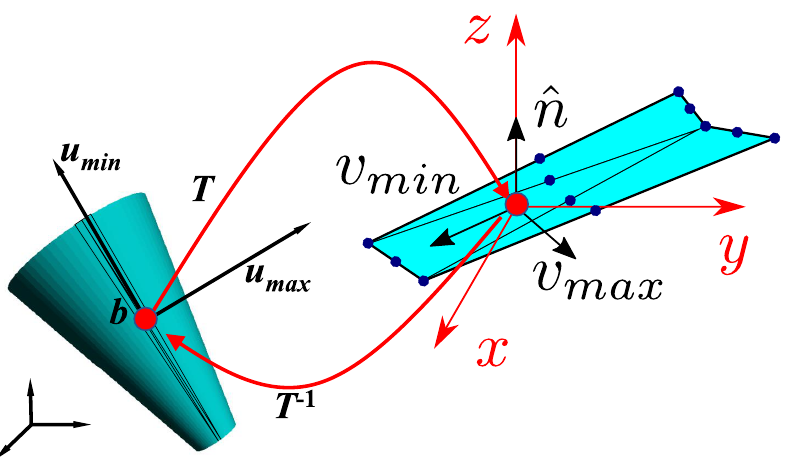
Figure 16. Rigid mapping M of local tangent plane of a ruled surface S onto the XY plane for the purpose of computing maximal and minimal curvature directions on S .